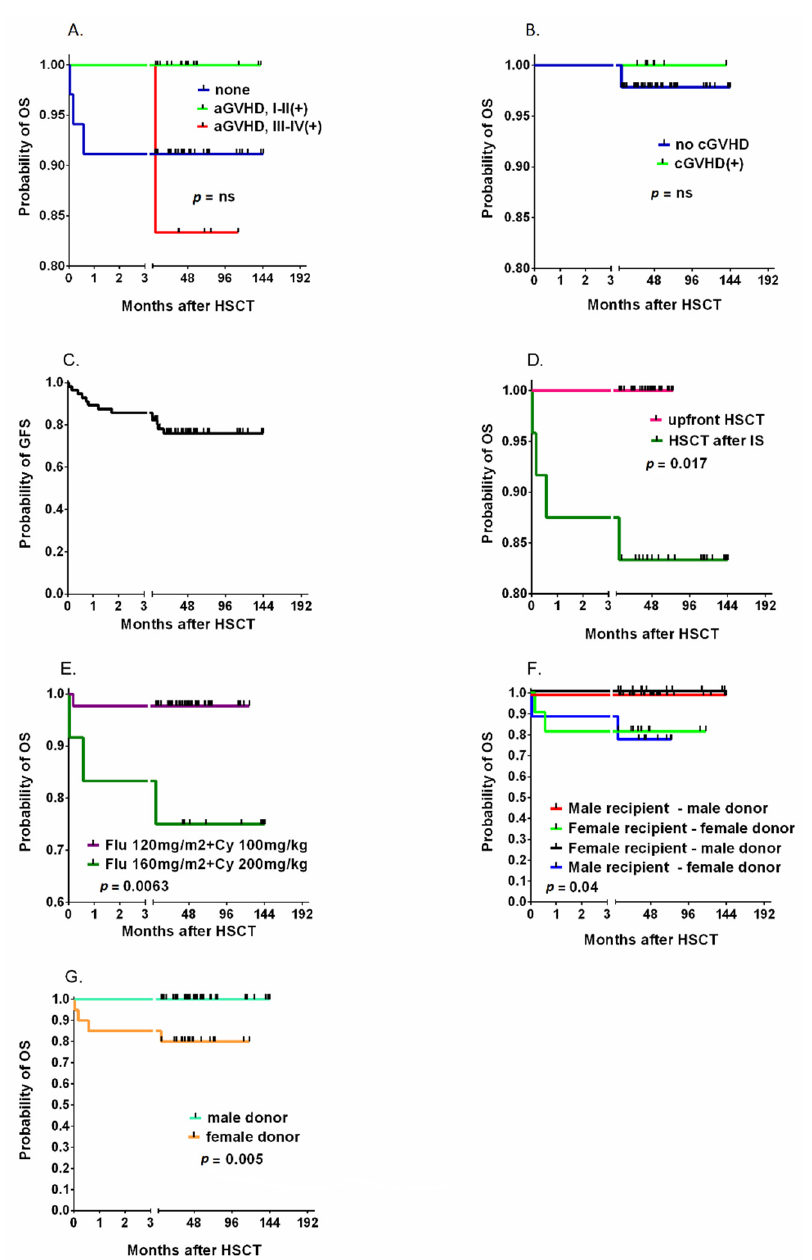
Figure 3. The cumulative incidence of acute GVHD ( A ) and chronic GVHD ( B ) and the probability of graft-free survival ( C ) after HSCT. The impact of pretransplantation immunosuppressive therapy (IS) ( D ) and the intensity of the chemotherapy protocol ( E ) on the probability of OS. The role of recipient and donor genders ( F ) and of donor genders ( G ). Legend. OS, overall survival; GFS, graft versus host disease-free survival; HSCT, Allogeneic hematopoietic cell transplantation; Flu, fludarabine; Cy, cyclophosphamide; GVHD, graft versus host disease; aGVHD, acute graft versus host disease; cGVHD, chronic graft versus host disease.